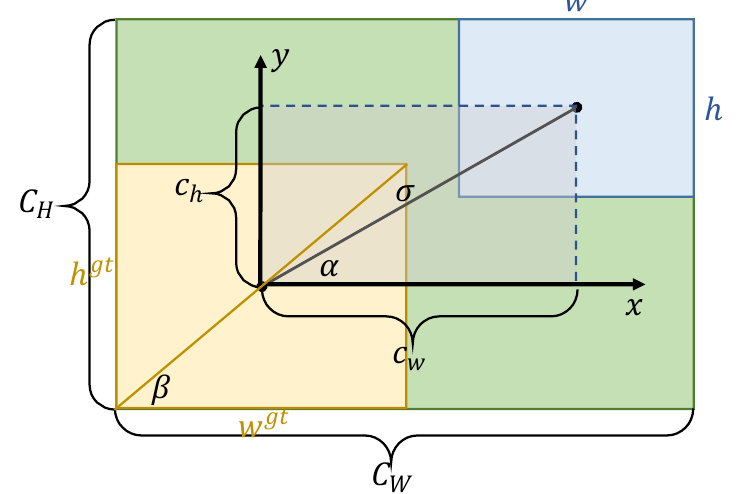
Figure 5. Schematic diagram of SIoU. The yellow box refers to the ground-truth box, the blue box refers to the predicted box, and the green area refers to the minimum external rectangle of the two boxes